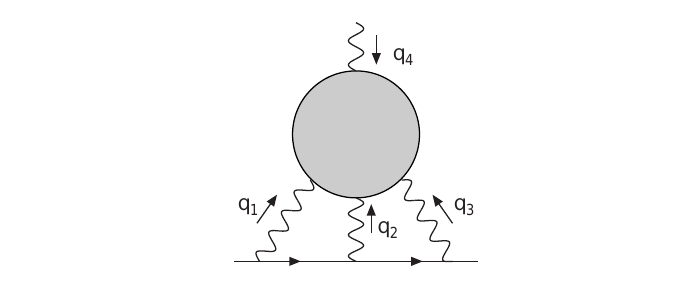
Figure 1. The HLbL topology. The grey blob connecting to the external muon line contains all hadronic